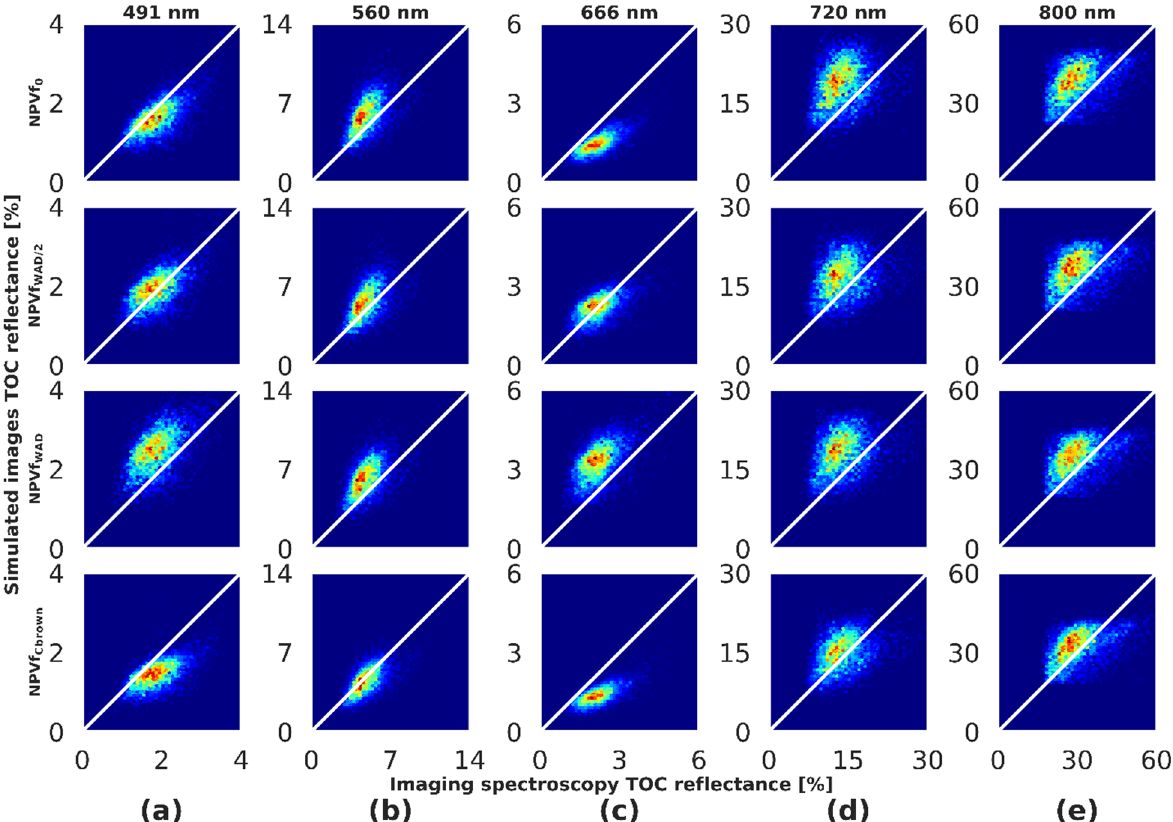
Figure 9. Relationship between Imaging spectroscopy and DART simulations top of canopy (TOC) reflectance. ( a ) 491 nm; ( b ) 560 nm; ( c ) 666 nm; ( d ) 702 nm and ( e ) 800 nm. From top to bottom: NPVf 0 ; NPVf WAD/ 2 ; NPVf WAD and NPVf Cbrown .